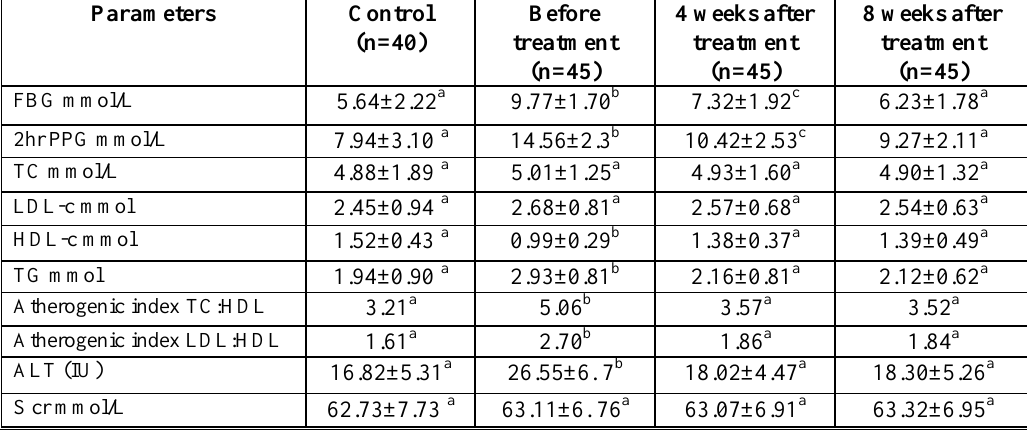
Table 3: Effects of Rosiglitazone on the serum fasting blod glucose , 2hrs-postprandial glucose , lipid profile ,triglycerides , alanine aminotransferase , and serum creatinine after 4 and 8 of weeks of treatment